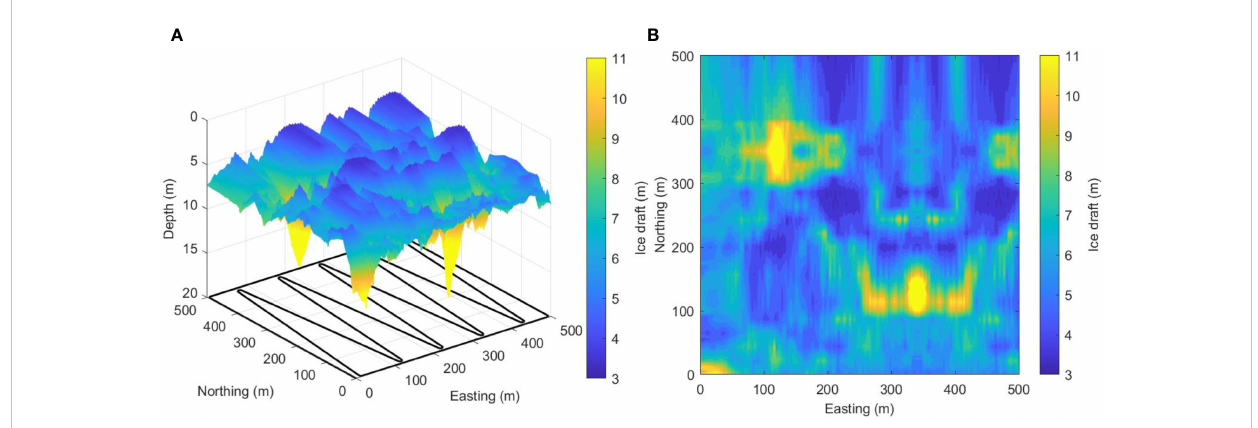
FIGURE 5 Ice draft map of testing scenario (Black solid lines present the predetermined trajectory for rough mapping). (A) 3D mapping of ice draft. (B) Underwater ice thickness surface in 2D.